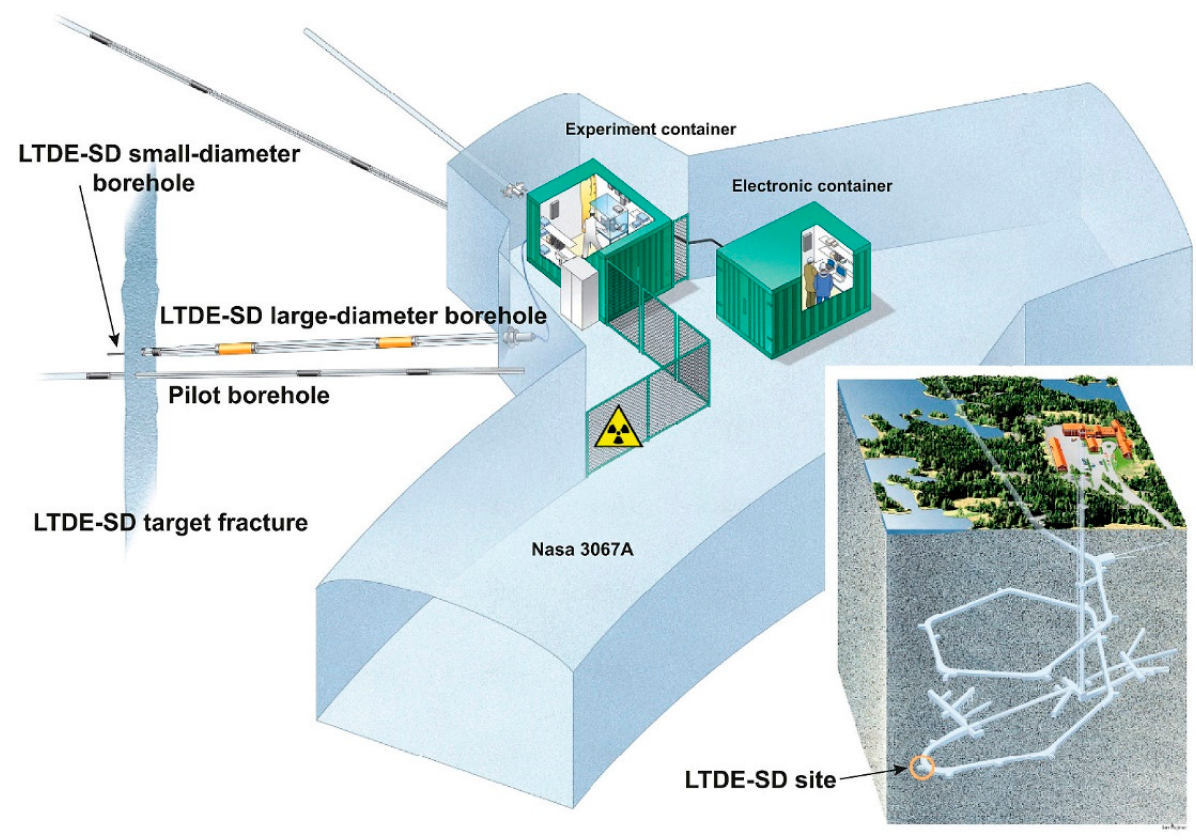
Figure 6. Illustration of the LTDE-SD experimental site at the ÄHRL, Sweden (from